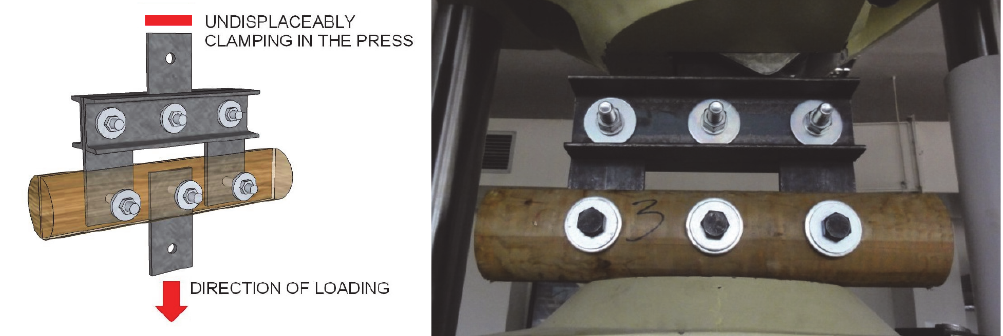
Figure 1: Steel product for testing in tension perpendicular to the grain and sample in press